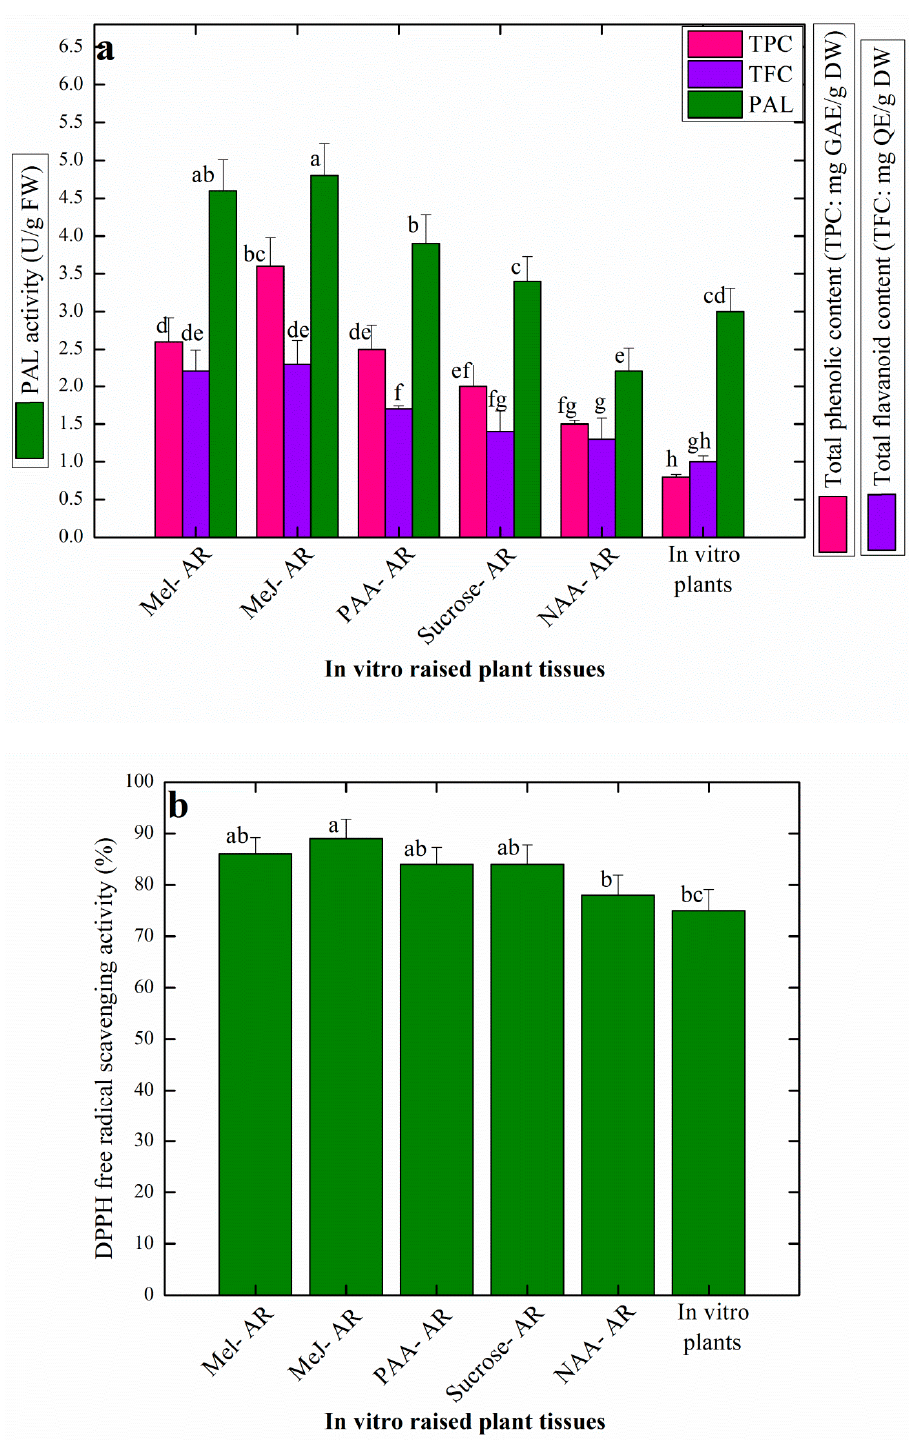
Figure 3. Evaluation of antioxidant secondary metabolites in the in vitro-raised AR in response to di ff erent elicitor treatments and control. ( a ) Total phenolic content (TPC), total flavonoid content (TFC) and phenylalanine ammonia-lyase activity; ( b ) DPPH free radical scavenging activity. Data represent the mean values of triplicates with ± standard error. Mel-AR: Melatonin treated AR, Me-J-AR: Methyl jasmonate treated AR, PAA-AR: Phenyl acetic acid treated AR, Sucrose-AR: AR established on solid MS media containing 1.0 mg / L NAA and 4% sucrose, NAA-AR: AR established on solid MS media containing 3% sucrose and 1.0 mg / L NAA. Data represent the mean values of triplicates with ± standard error. Annotation of columns data with di ff erent alphabet (s) represents the significance at ( P =